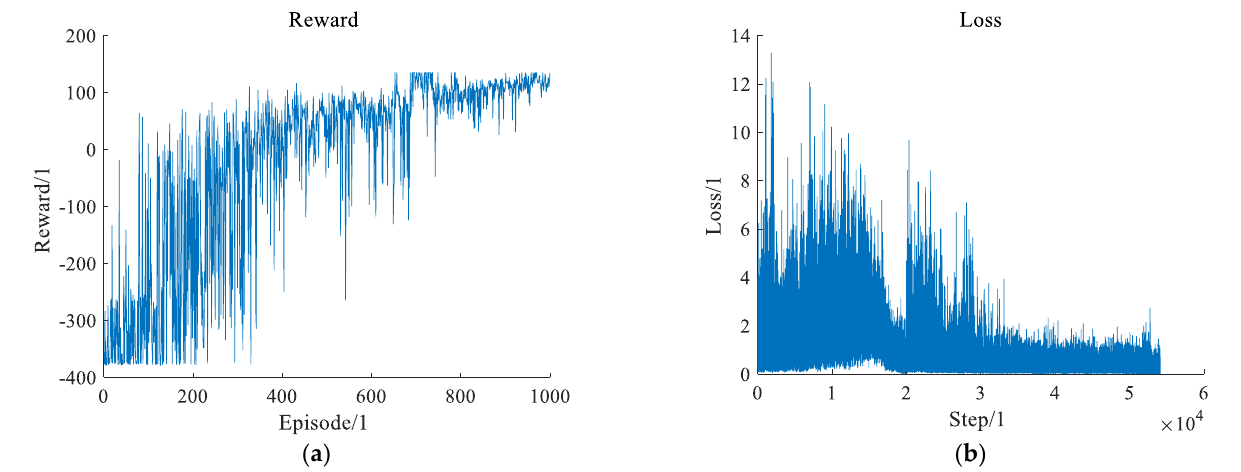
Figure 4. Training process based on CR-DRQN. ( a ) presents the change of the reward obtained by the intelligent vehicle with the increase of episodes. ( b ) presents the relationship between the loss and update steps.